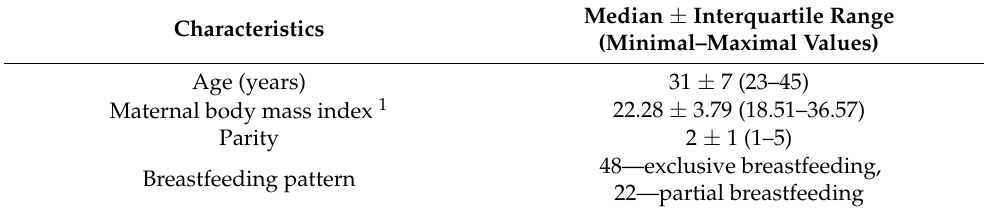
Table 1. Maternal characteristics.